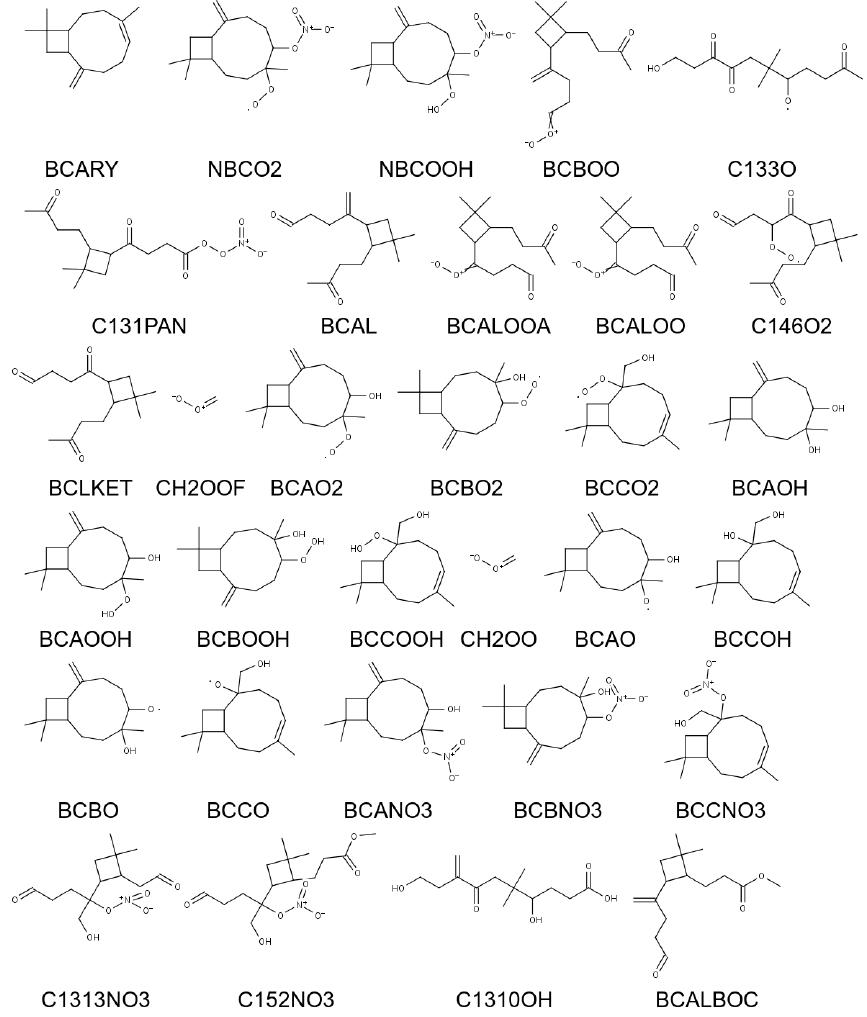
Figure C1. Molecular structures of the MCM species that are mentioned in the paper. For more information, please visit the MCM website.